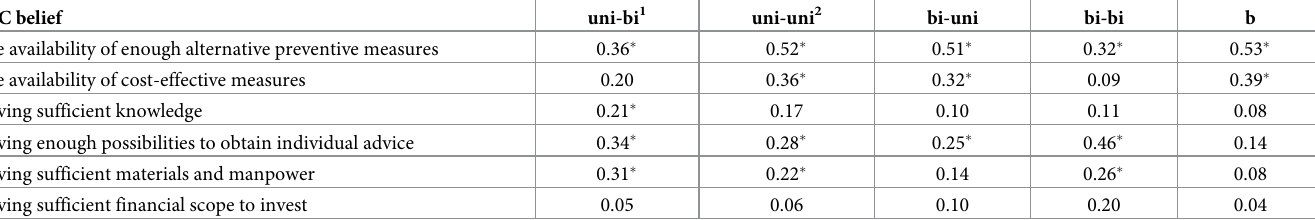
Table 7. Correlation coefficients between the PBC belief score (b) and the PBC construct, and between the four PBC multiplicative composites (uni-bi, uni-uni, bi- uni, bi-bi), and the PBC construct. PBC